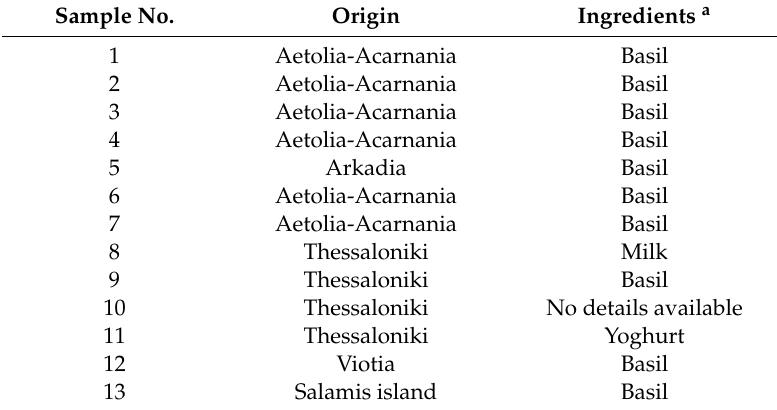
Table 1. Sourdough samples analyzed in the present study. Sample No. Origin Ingredients a